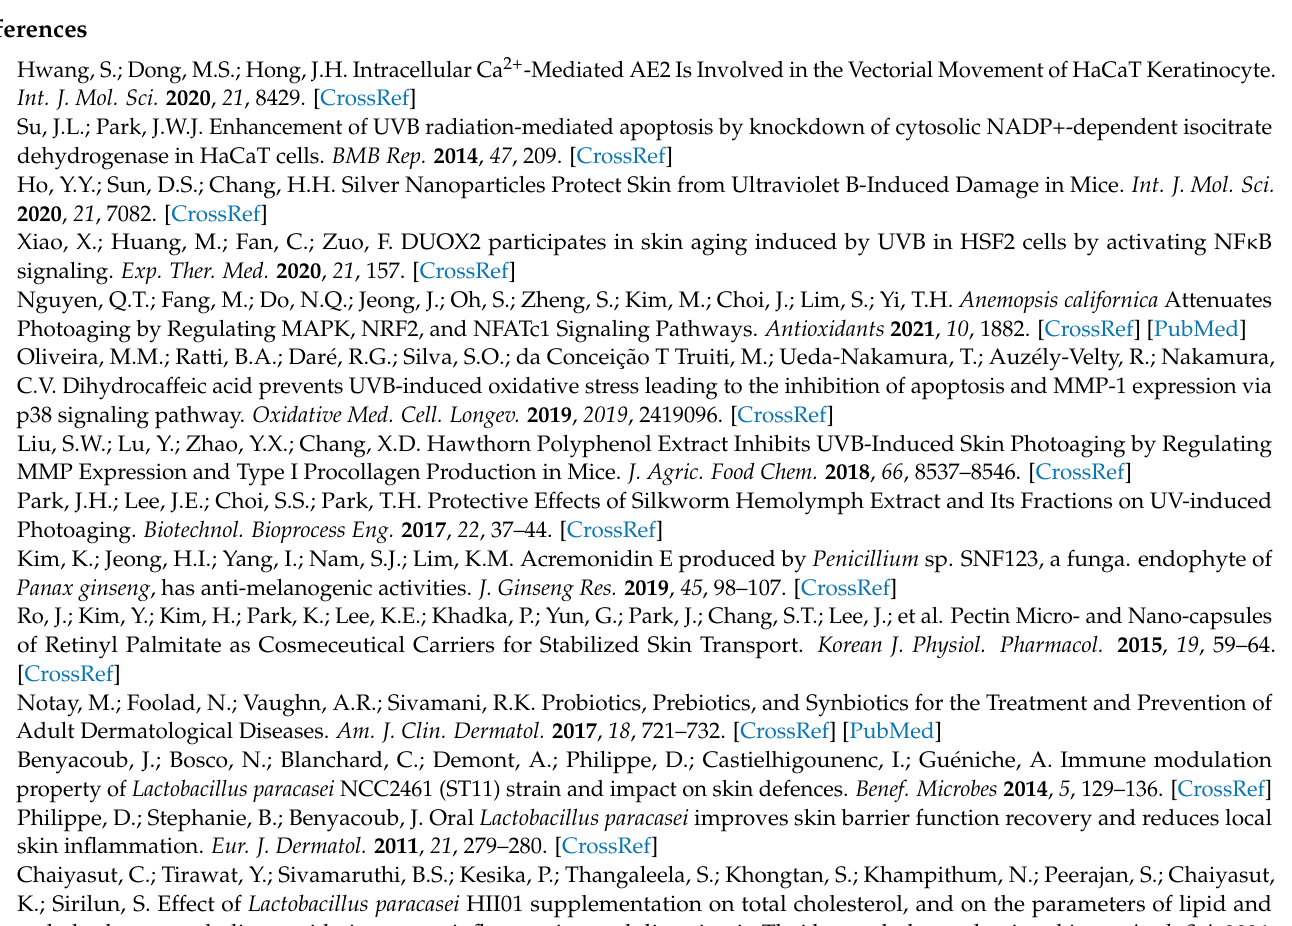
Table S2: List of correlation coefficient of related parameters in NHDF and B16F10